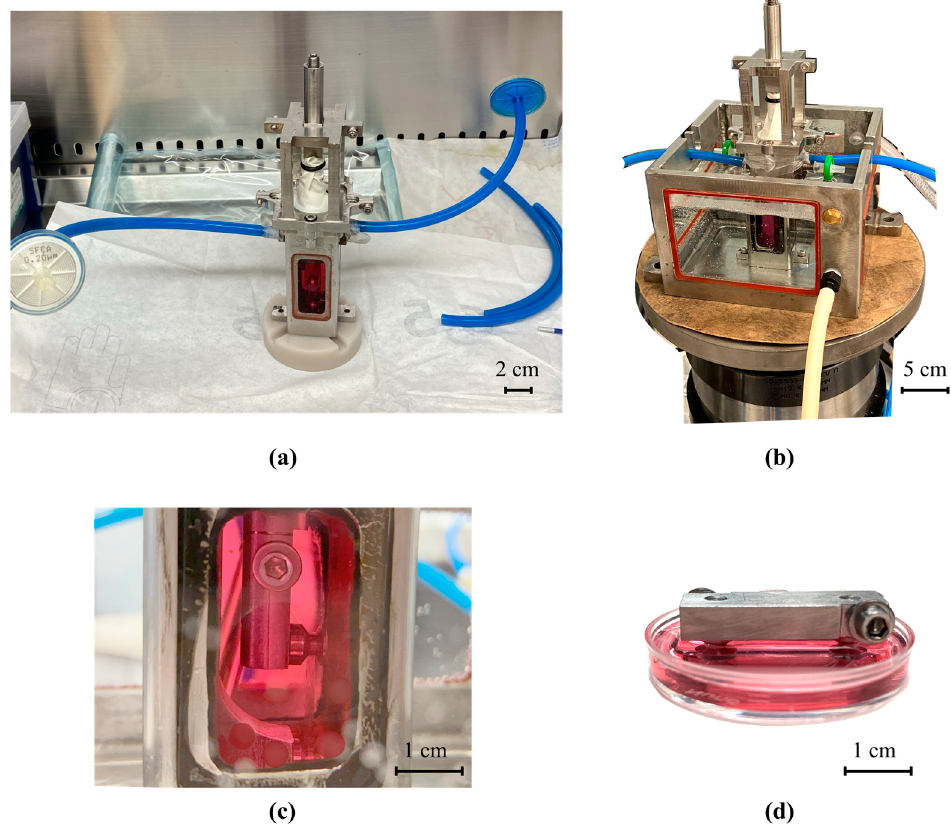
Figure 6. ( a ) Closed bioreactor with input and output circulation hose; ( b ) in-vitro study system; ( c ) scaffold in the mobile grip inside the bioreactor; ( d ) static grip with the scaffold. 3.2. Cell Viability Results on the Microfilament Scaffolds Cell proliferation was assessed as the viability percentage (%) shown in Equation (1).